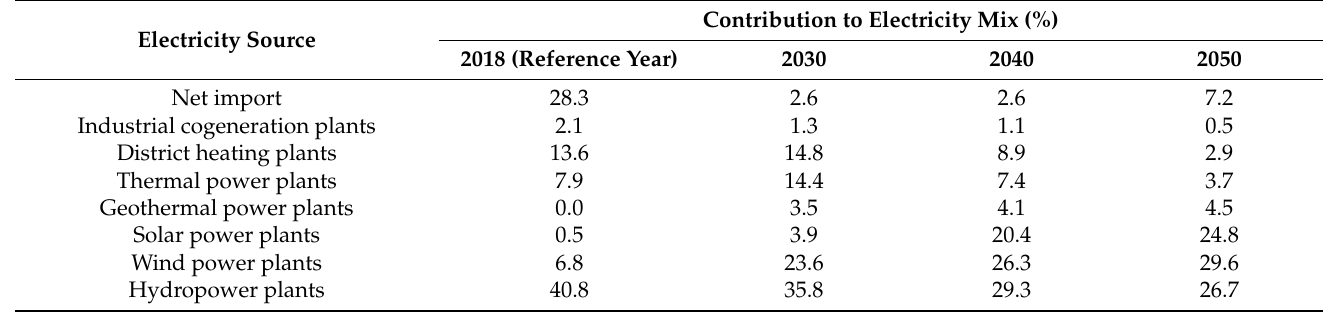
Table 3. Electricity mix projections for